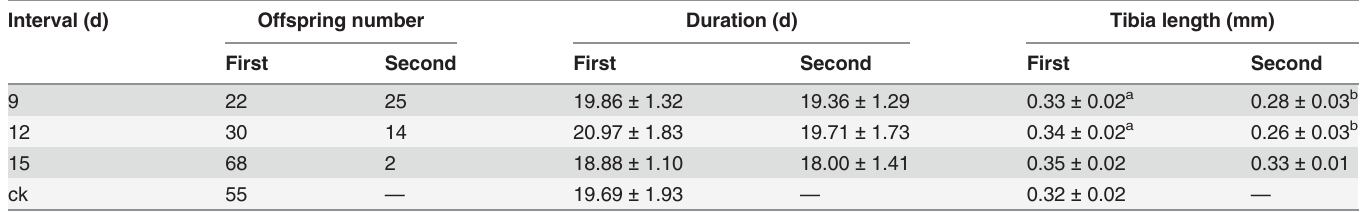
Table 1. Developmental duration and size of P . vindemmiae offspring at the first and second emerging events from hosts exposed twice with dif- ferent intervals. Interval (d)